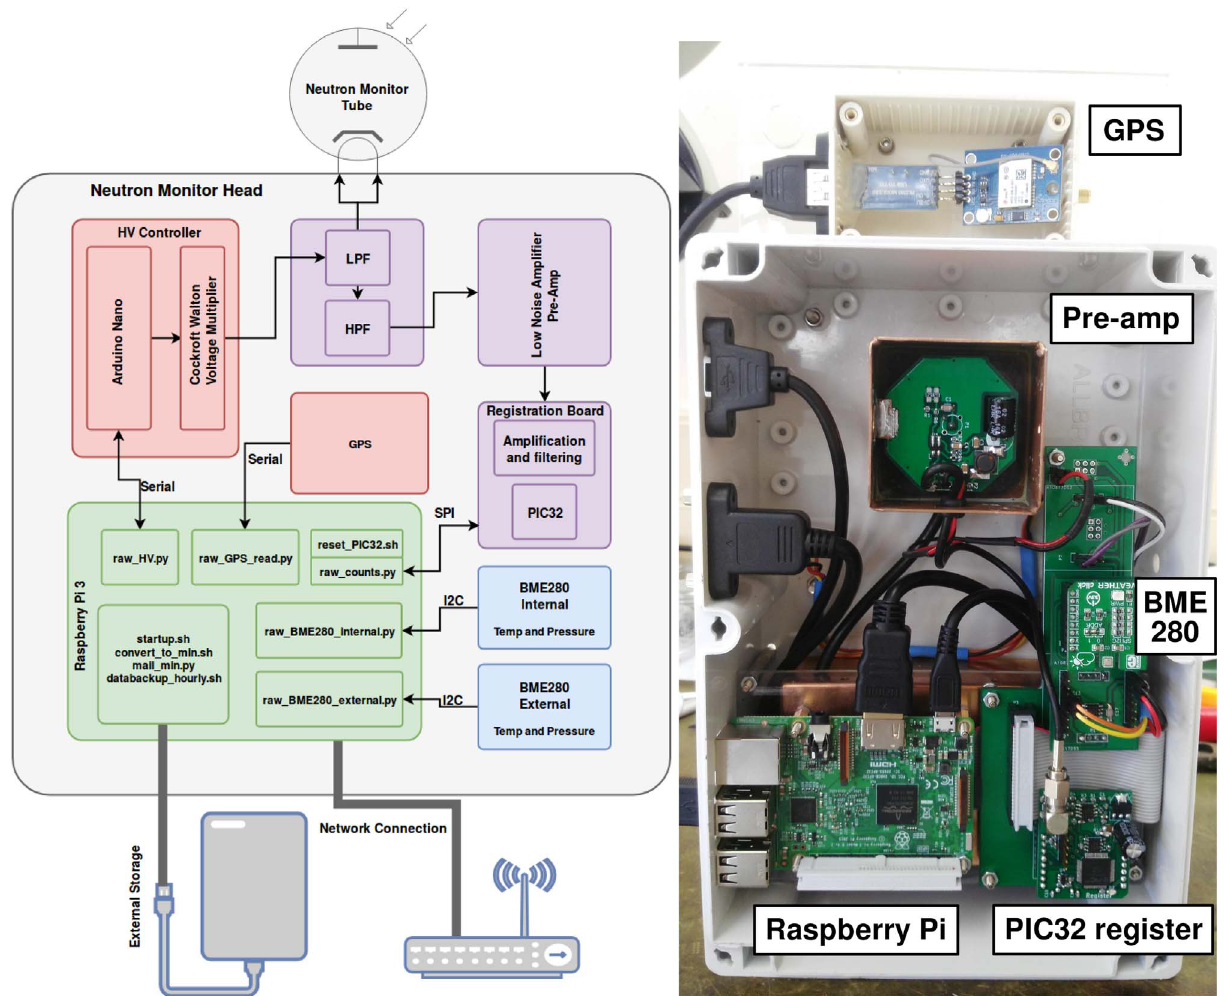
Fig. 3. The left panel shows a schematic representation of the mini-NM electronics head while the right panel shows the actual components, with the front cover